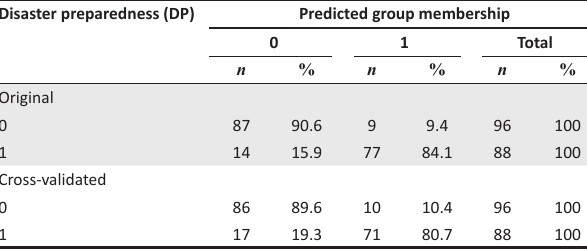
TABLE 7: Classification results.